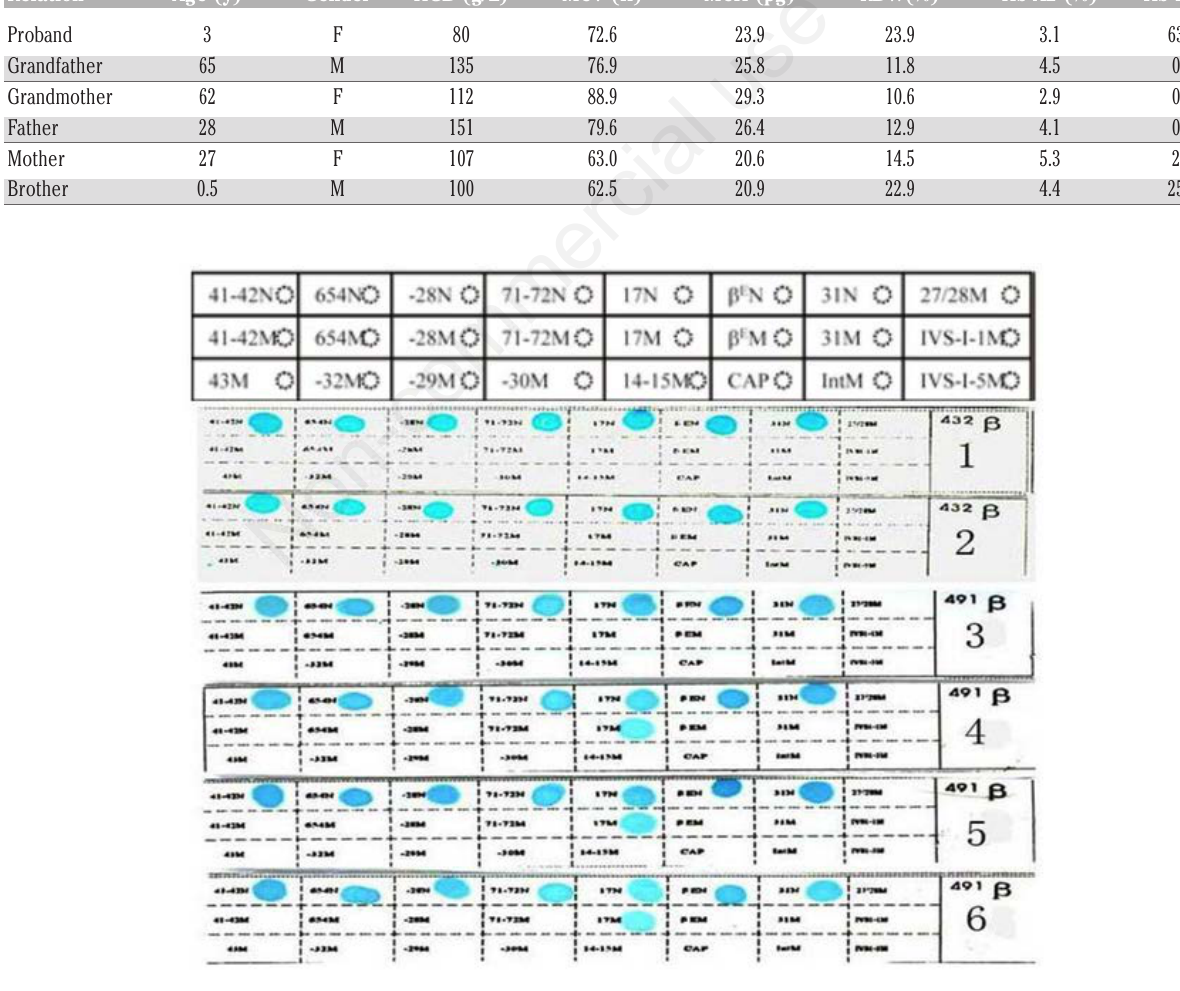
Figure 1. Detection of seventeen common Chinese mutations by reverse dot blot. 1) Grandfather, 2) Grandmother, 3) Father, 4) Mother, 5) Proband, 6)